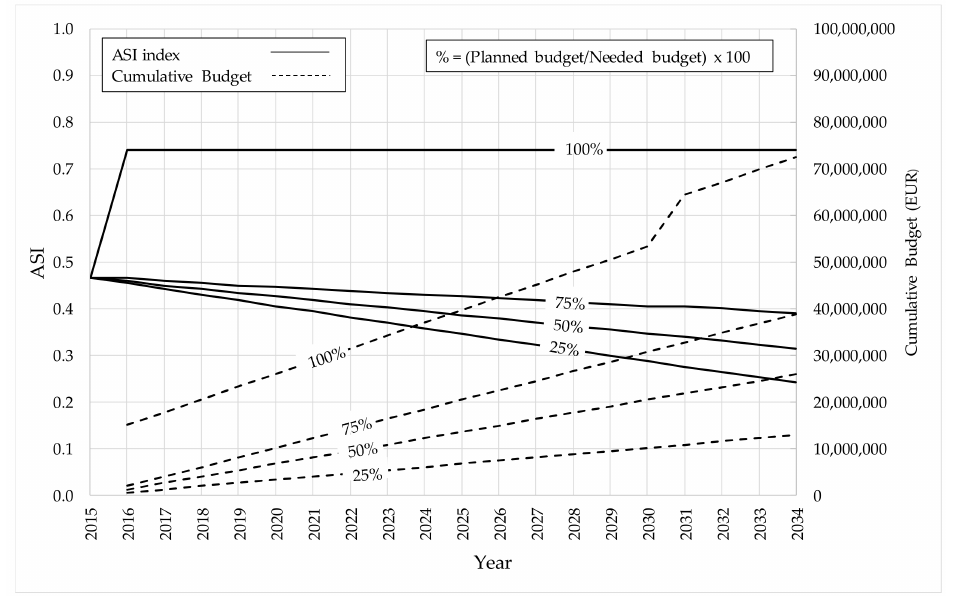
Figure 14. Asset 2 condition assessment with ASI under several future investment